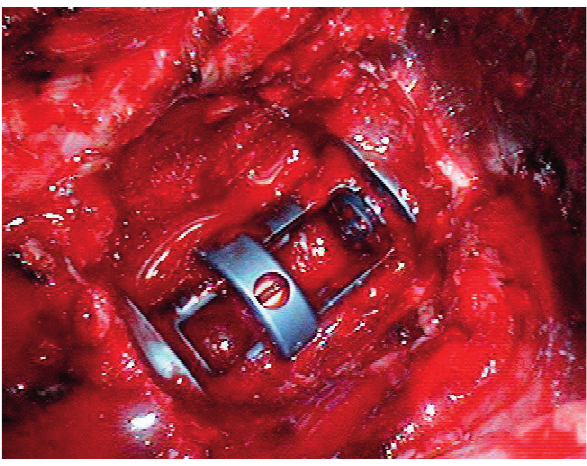
Fig. 4. OP view expandable cage in correct position. segment, the diaphragm must be incised to the extension of the incision of the parietal pleura. Screws are placed to the vertebral bodies under sciascopic control. Discs and endplates of vertebral bodies are removed. This is the time to measure the size of the replacement of the vertebral body by a gauge and choose the proper allograft or tita- nium implant to replace the vertebral body. The next